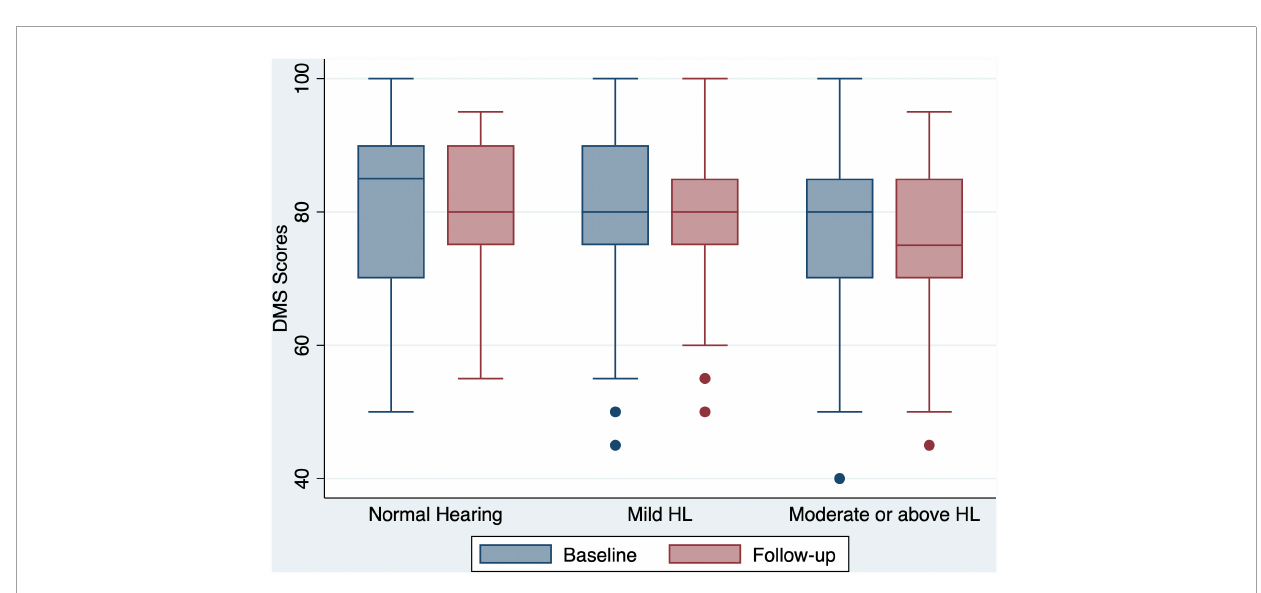
FIGURE2 Box and whisker plot of DMS correct percent and quartiles at baseline and follow-up, according to the HL categories. Any outlier at baseline/follow-up is shown by a dot. DMS, delayed matching to sample; HL, hearing